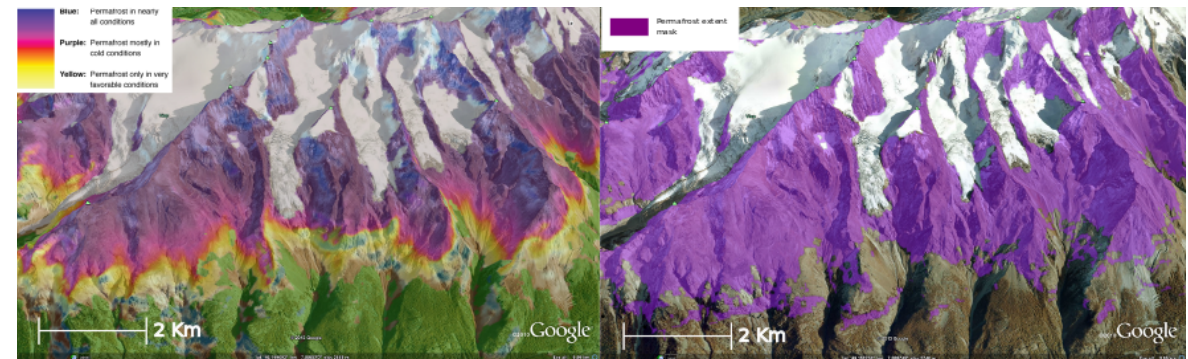
Figure 8. Visual comparison of permafrost extent computed by (a) this study (MS setup) and (b) a state-of-the-art statistical model (Boeckli et al., 2012b). Comparison of model results, despite differences in the definition of permafrost area and in observation periods, is intended to demonstrate the similarity of patterns resulting from both